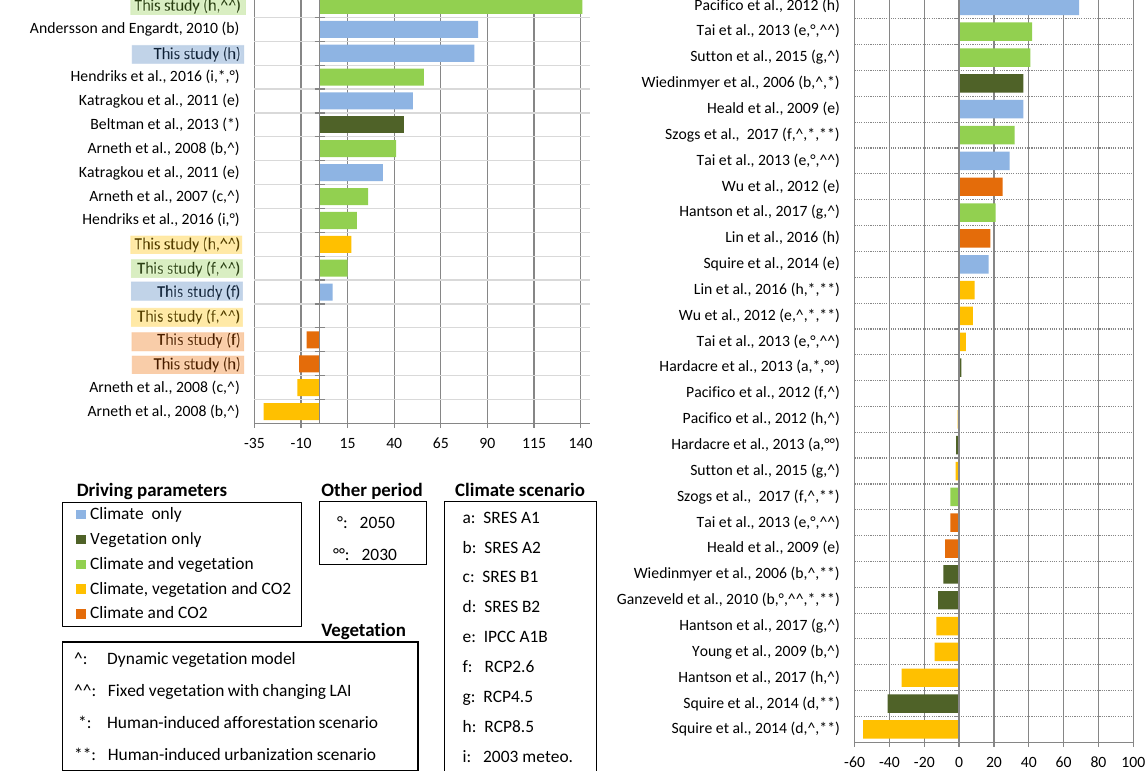
Figure 10. Comparison of our results to European (a) and global (b) changes in projected isoprene emissions predicted by different studies. The different colors indicate the driving parameters considered in the various simulations. Note that often several simulations are shown for the same study, to represent the impact of different parameters or climate scenarios assumed. The periods are end-of-century for all studies except otherwise